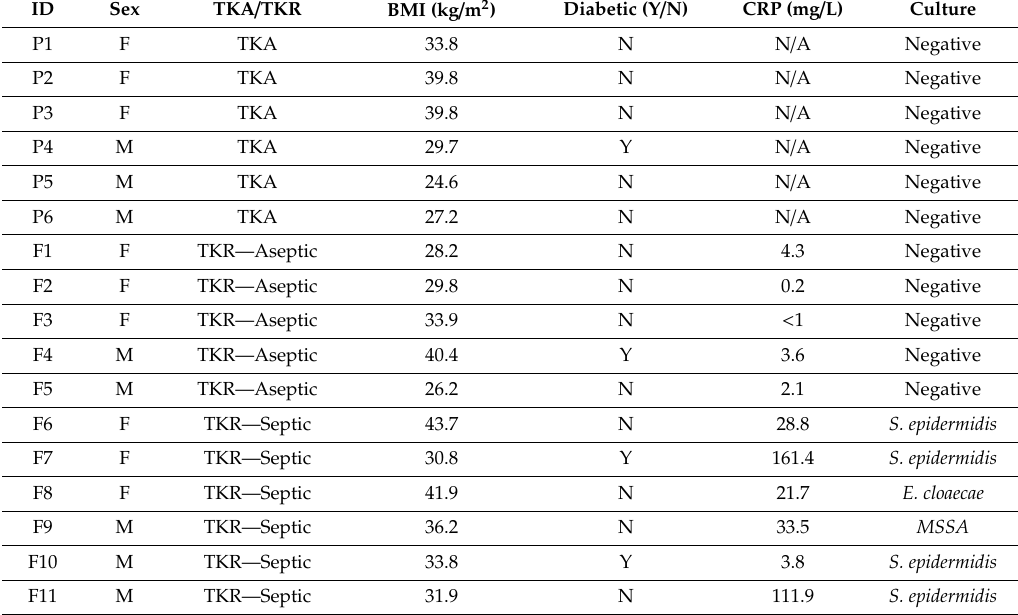
Table 1. Patient Information. Six primary total knee arthroplasty (TKA) and eleven revision total knee revision (TKR) patients were enrolled in the study, creating a heterogenous cohort of males and females varying in age (45–82 years) and comorbidities. Primary TKA patients have ID format P#;